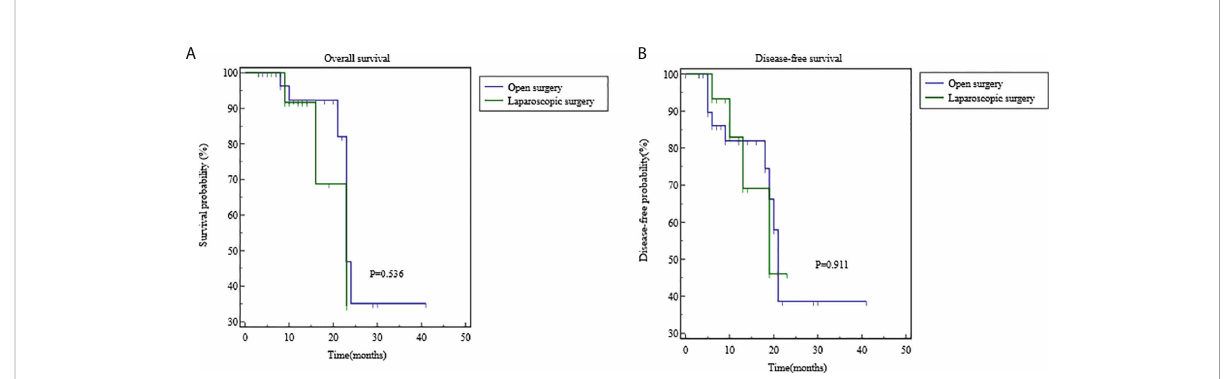
FIGURE 4 Comparisons of overall survival and disease-free survival using Kaplan-Meier curves. (A) the 1- year survival rates were 92.28% in the OS group and 91.67% in the LS group, and 2-year survival rates was 35.16% in the OS group and 34.37% in the LS group (P=0.536). (B) The 1-year disease- free survival (DFS) rate was 82.16% in the OS group and 82.96% in the LS group, and the 2-year DFS rate was 38.64% in the OS group and 46.09% in the LS group